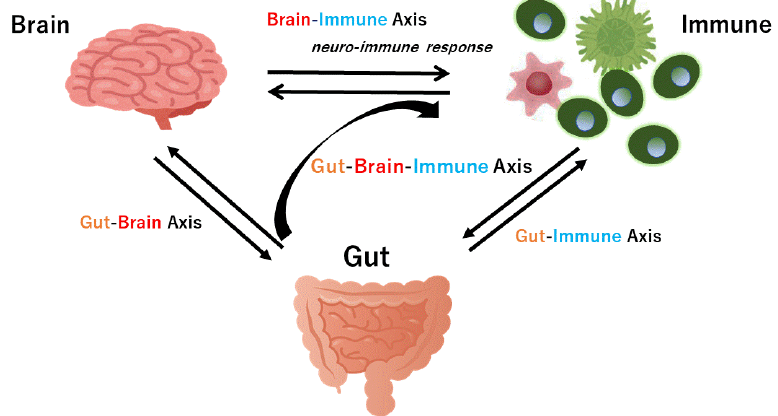
Figure 2. Hypothetical schematic overview and appearance of gut-brain axis cross-talk between the brain and the gut (intestine/ colon) in addition to the brain-immune axis and the gut-immune axis have been shown. Arrowhead means stimulation. Note that some key pathways such as the liver-brain axis have been excluded for